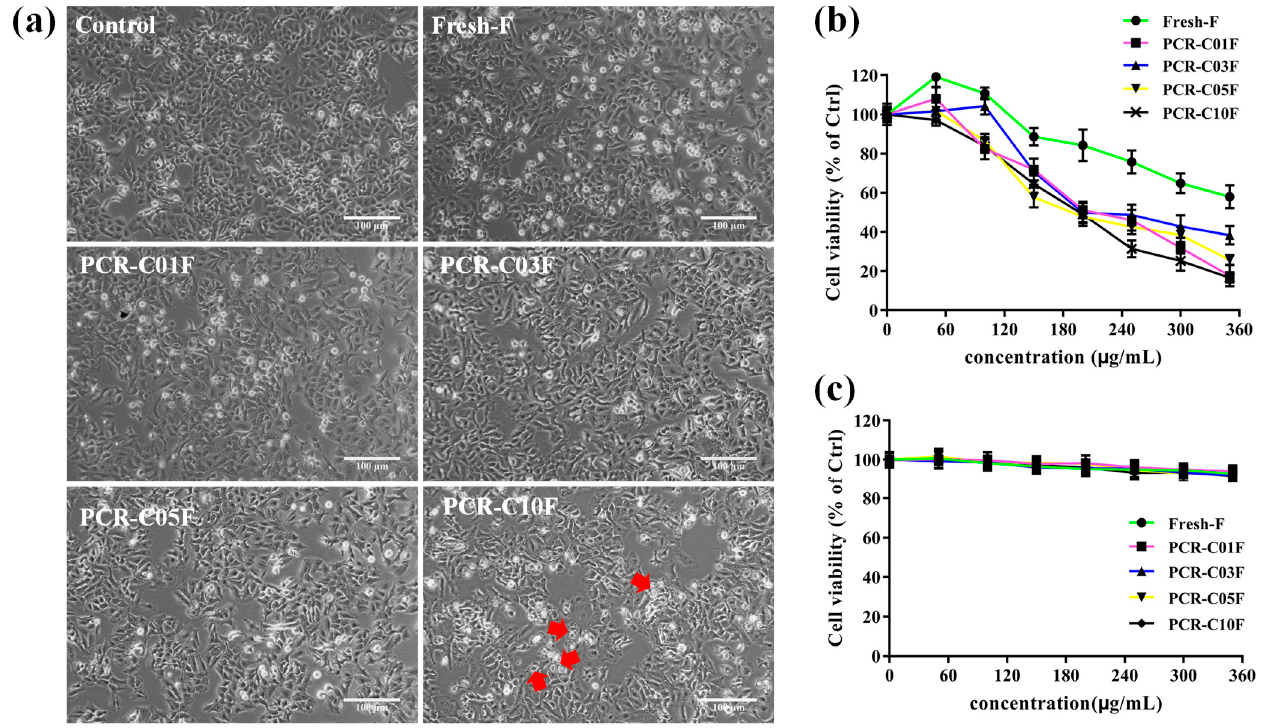
Figure 3. Growth inhibition effect of PCR-CF during storage on A549 cells. ( a ) Morphological changes of A549 cells that were treated with PCR-CF for 24 h under inverted phase-contrast microscopy (scale bar = 100 µ m). ( b ) Viability of A549 cells and ( c ) MRC-5 cells that were treated with PCR-CF at the gradient concentrations (50, 100, 150, 200, 250, 300, and 350 µ g/mL) for 24 h by MTT assay. Table 1. The IC 50 values of A549 cells that were treated with PCR-CF during storage. IC 50 Values ( µ g/mL)